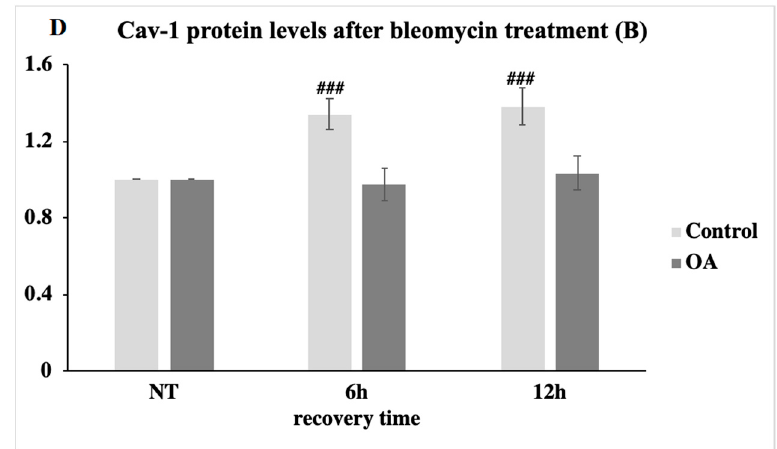
Figure 2. No alterations in caveolin-1 protein levels in osteoarthritic chondrocytes after exogenous oxidative insult. ( A ) Cell lysates of six control and six OA chondrocytes that have been exposed to H 2 O 2 and left to recover for 24 h were analysed at four different time points (NT, 1 h, 3 h, and 24 h/NT = No Treatment, 1 h= 1 hour, 6 h= 6 hour, and 24 h = 24 hour of recovery time post-treatment) by western blotting using the anti-caveolin-1 (Cav-1) antibody. Antibody against GAPDH was used as loading control. ( B ) Cell lysates of the control and OA chondrocytes that have been exposed to bleomycin for 6 h and 12 h were analysed with western blotting using anti-caveolin-1 (Cav-1) antibody. GAPDH was used as the loading control. ( C ) Quantification of relative protein expression levels of caveolin-1 in cell lysates from control (control) and osteoarthritic chondrocytes (OA) after being exposed to H 2 O 2 was performed based on band density using ImageJ. ( D ) Quantification of the relative protein expression levels of caveolin-1 in cell lysates from the control and OA chondrocytes after being exposed to bleomycin was performed based on band density using ImageJ. To calculate the differences of protein expression between each time point versus the No Treatment (NT) condition, protein expression levels at NT were arbitrary set to 1. Analyses were performed three times using cell lysates from six healthy donors and six OA patients. Values shown are the means ± S.E. ### p < 0.001 versus the NT condition. p values were calculated using the Student t -test.